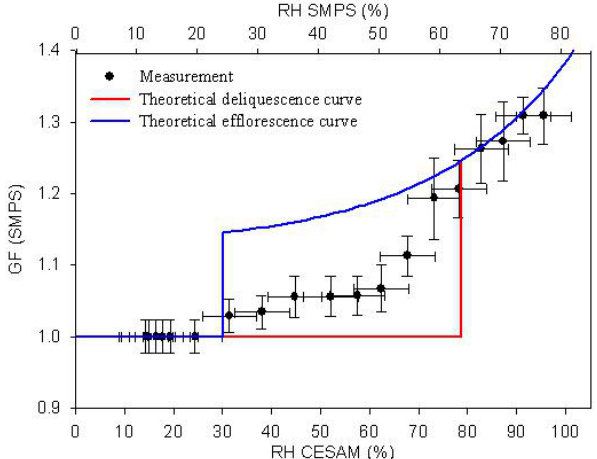
Fig. 12. Hygroscopic growth factor GF as a function of RH within the chamber (bottom axis) and the RH within the measuring instru- ment (upper axis) obtained for the experiment E1212. The mea- surements (black circles) are compared with the theoretical growth factors based on the Köhler theory for deliquescence (red line) and efflorescence (blue line). Theoretical curves take into account the Kelvin effect for particles smaller than